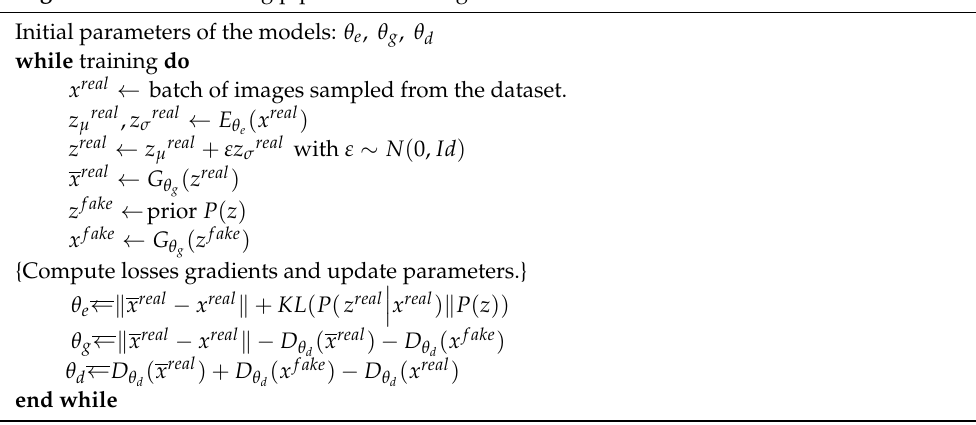
Algorithm 1: The training pipeline of the stage